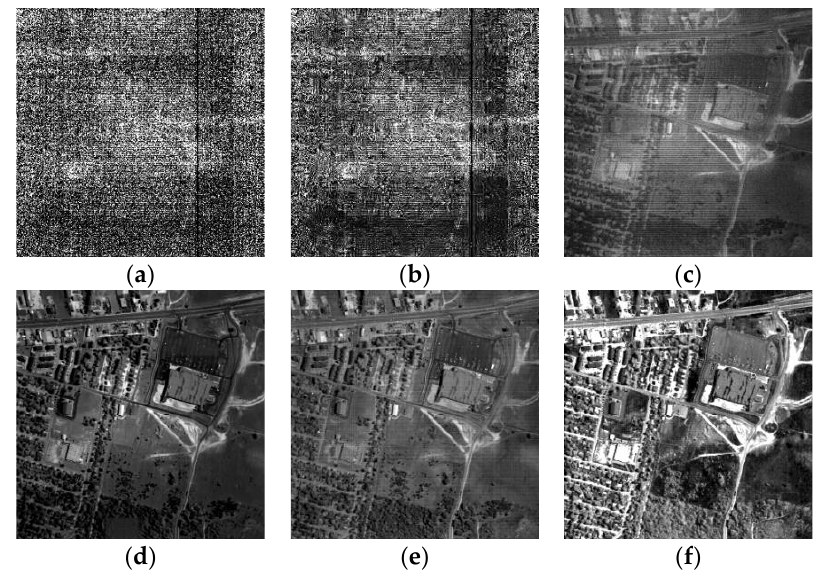
Figure 8 Inpainting results of band 144 of Urban dataset. ( a ) Original image; ( b ) PDE; ( c ) UBD; ( d ) LLRSSTV; ( e ) BPFA; and ( f ) INORSDL.